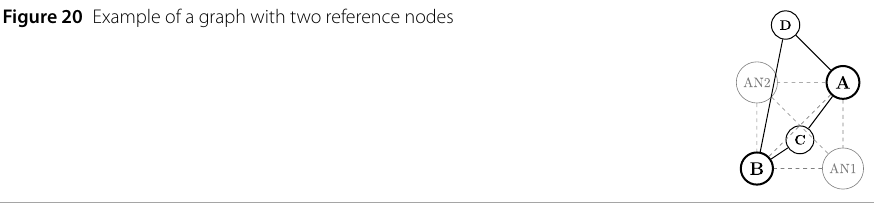
Figure 20 Example of a graph with two reference